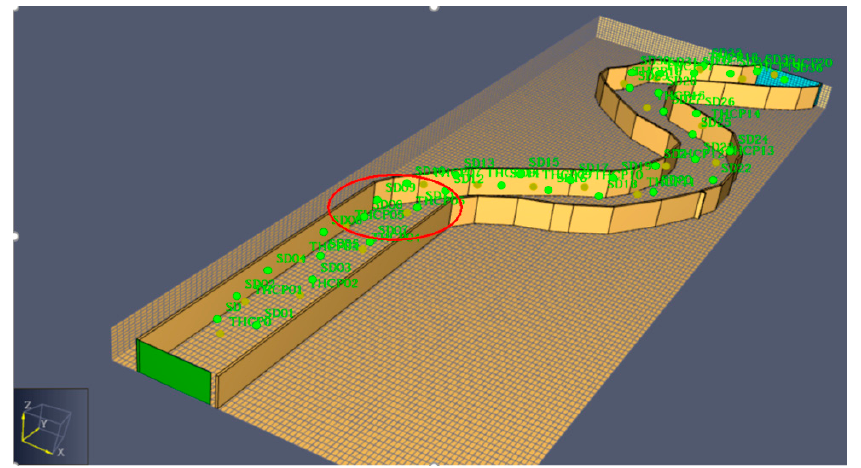
Figure 8. Software model diagram.